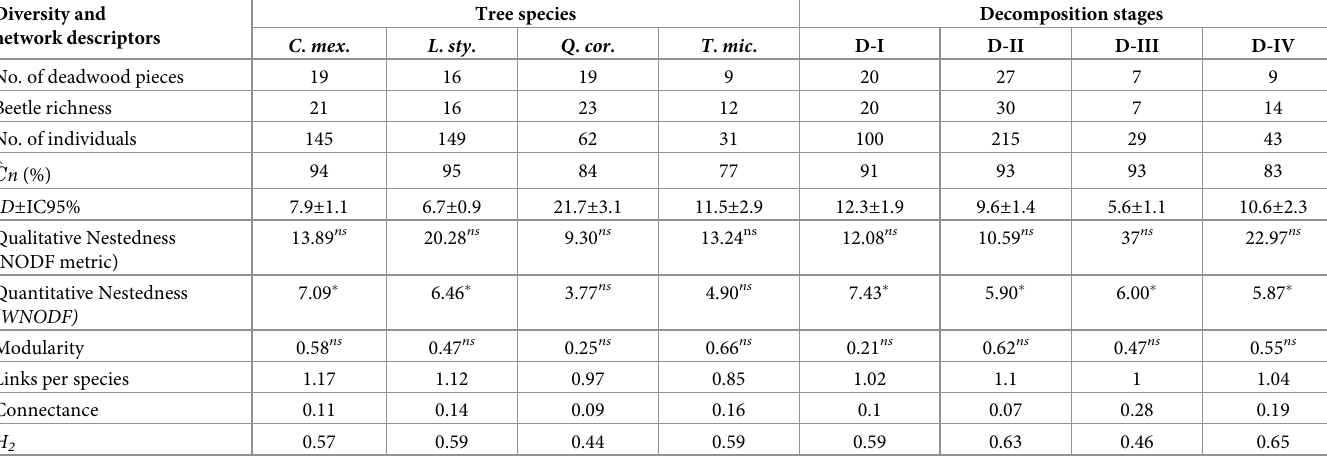
Table 1. Diversity and network patterns. Relationship of the diversity estimators and network values found through the four tree species and the four deadwood decom- position stages evaluated from the riparian cloud forest in the “La Antigua” basin, central Veracruz. Diversity and Tree species Decomposition stages network descriptors